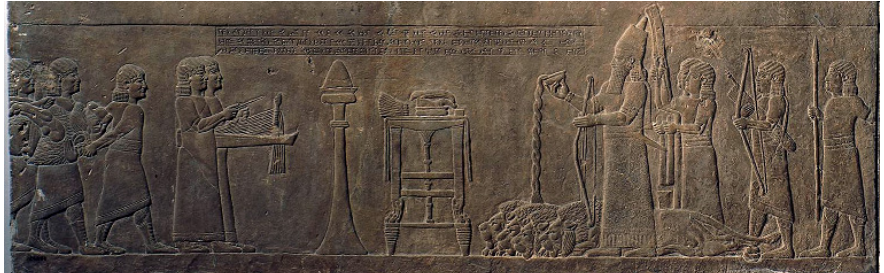
Figure 17. King Ashurbanipal pouring wine libation over four dead lions, surrounded by attendants (BM inv. no. 124886; reg. no. 1856,0909.51); gypsum relief (lower register); North Palace (Room S), Nineveh (mod. Iraq); Neo-Assyrian, ca. 645–635 BCE [image courtesy of the Trustees of the British Museum, London].